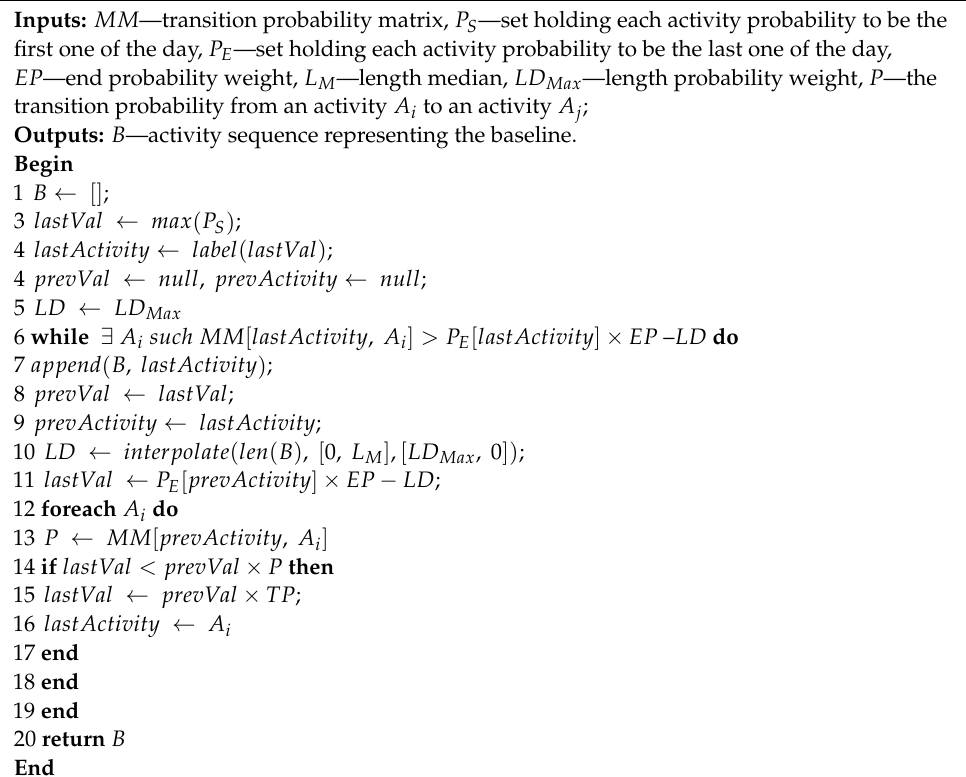
Algorithm 1: Baseline detection considering both activity sequence and activity